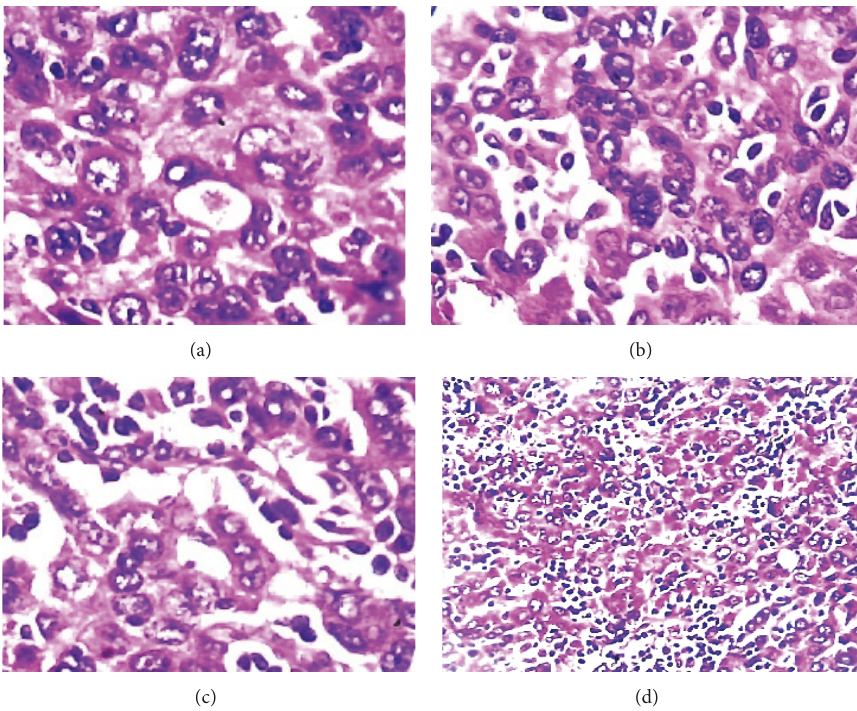
Figure 3: (a, b, c) Abortive tubular formations ( HE 200x ); (d) massive lymphoid infiltration occupying sinusoidal space and disrupting the trabecular architecture ( HE 100x